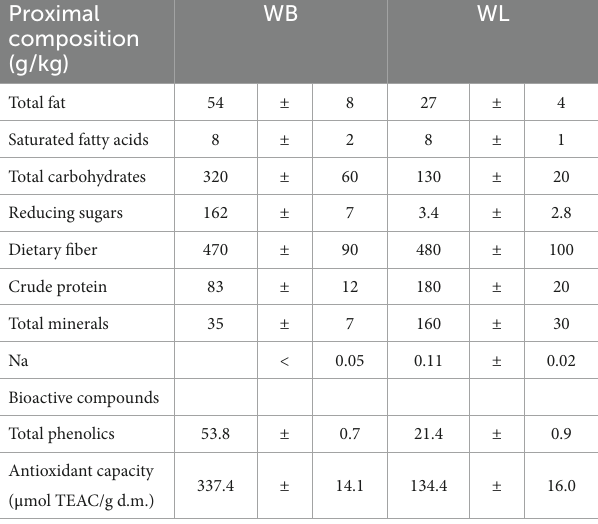
TABLE 1 Proximal composition and total phenolics in red wine bagasse (WB) and lees (WL). Proximal